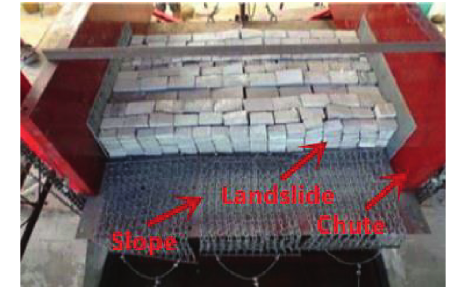
Figure 2: Test chute.